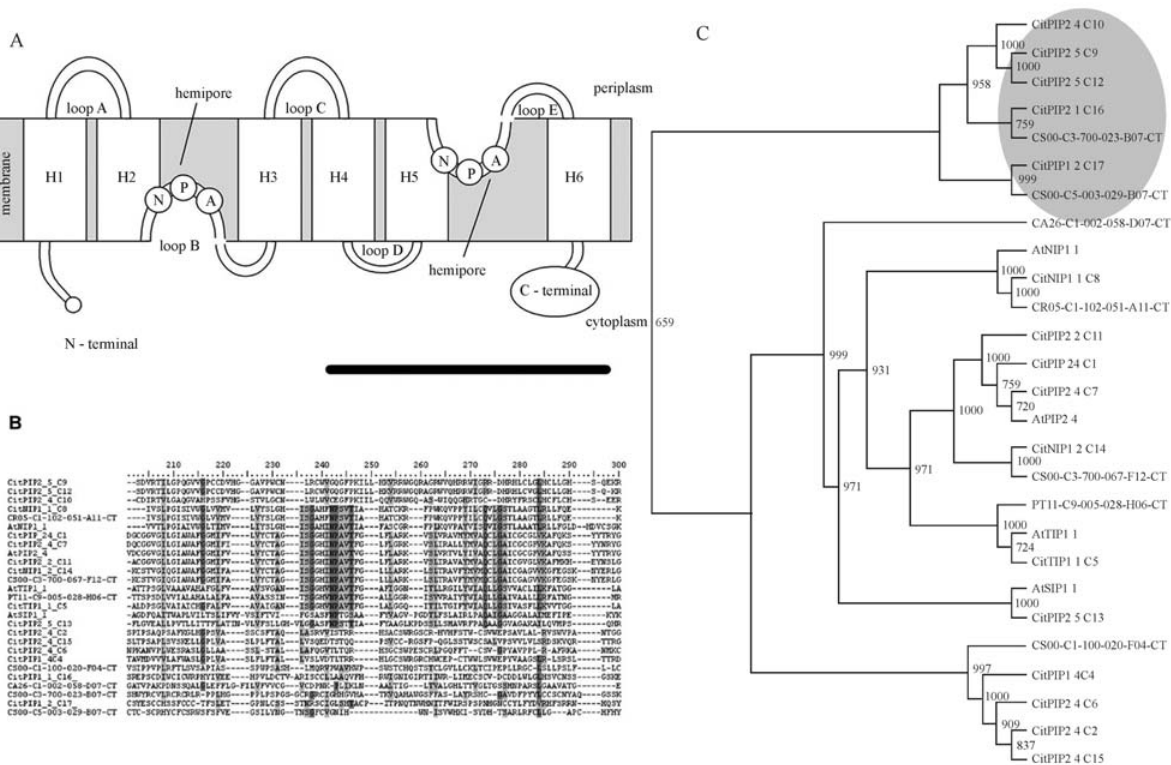
Figure 2 - Citrus membrane intrinsic proteins (MIP). (A) Schematic representation of the domain organization of plant MIP family. (B) Sequence align- mentofloopC,H3,H4,loopDandH5domainsfrom Arabidopsis MIPproteinsandtheircitruscounterparts.(C)Phylogeneticanalysisofdeducedamino acid sequence of citrus MIPs and prototypical representatives of A. thaliana PIP, TIP, NIP and SIP families. The shaded circle represents a citrus exclu- sive clade of divergent PIP-like